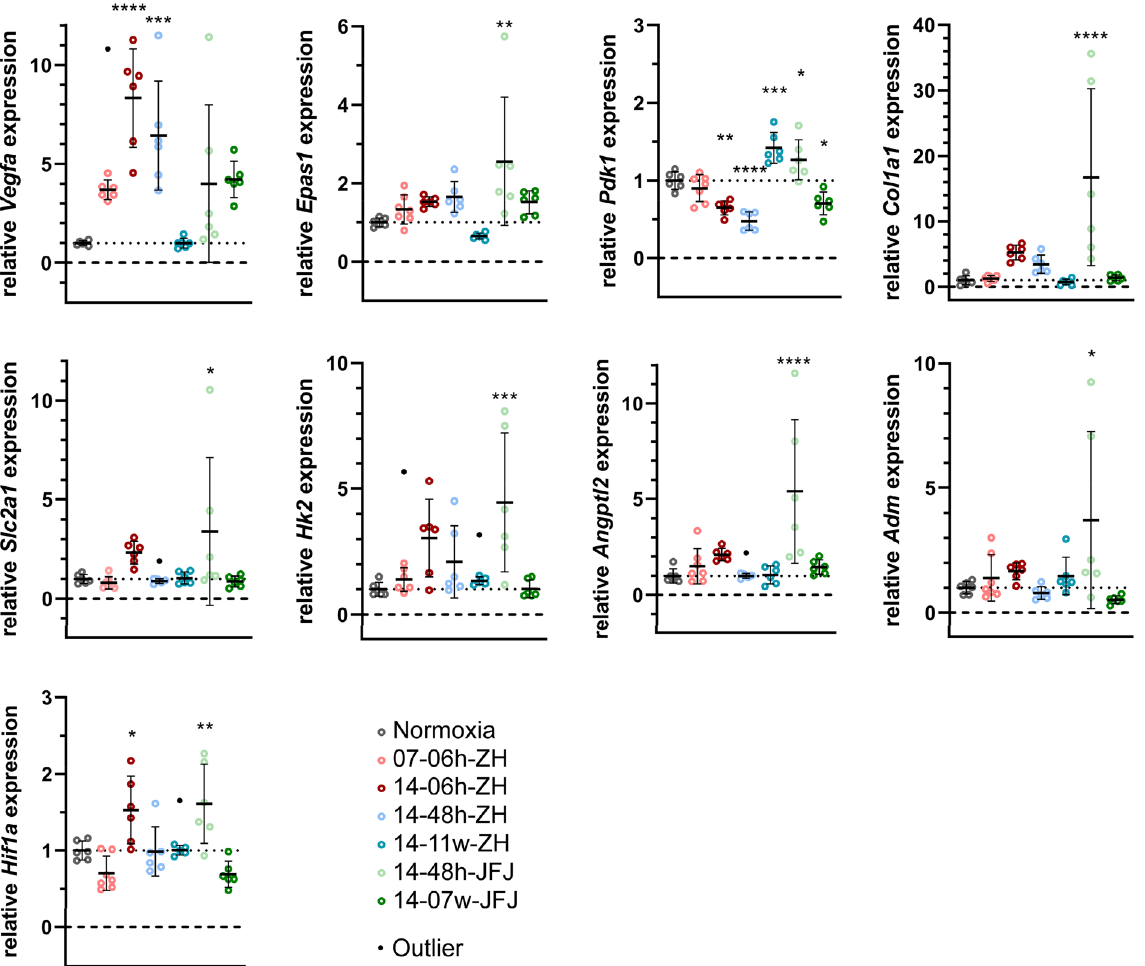
Figure 4. Differentially expressed genes in the RPE. Expression of genes related to the hypoxic response ( Hif1α, Epas1, Slc2a1, and Adm ), glycolysis ( Pdk1, Hk2 ), vascular perfusion ( Vegfa, Angpt2 ), and choroidal connective tissue ( Col1a1 ) was tested in eyecups by semiquantitative real-time PCR for all hypoxic conditions, as indicated. Expression levels were normalized to Actb and are shown relative to normoxic controls, which were set to 1 (dotted line). Shown are means ± SD of n = 6. Outliers detected by Grubb’s test (α = 0.01) are indicated as black dots and were excluded from statistical analysis. Significant differences of each condition to control (normoxia) was tested by one-way ANOVA with Dunnett’s multiple comparison test * p < 0.05; ** p < 0.01; *** p < 0.001; **** p <